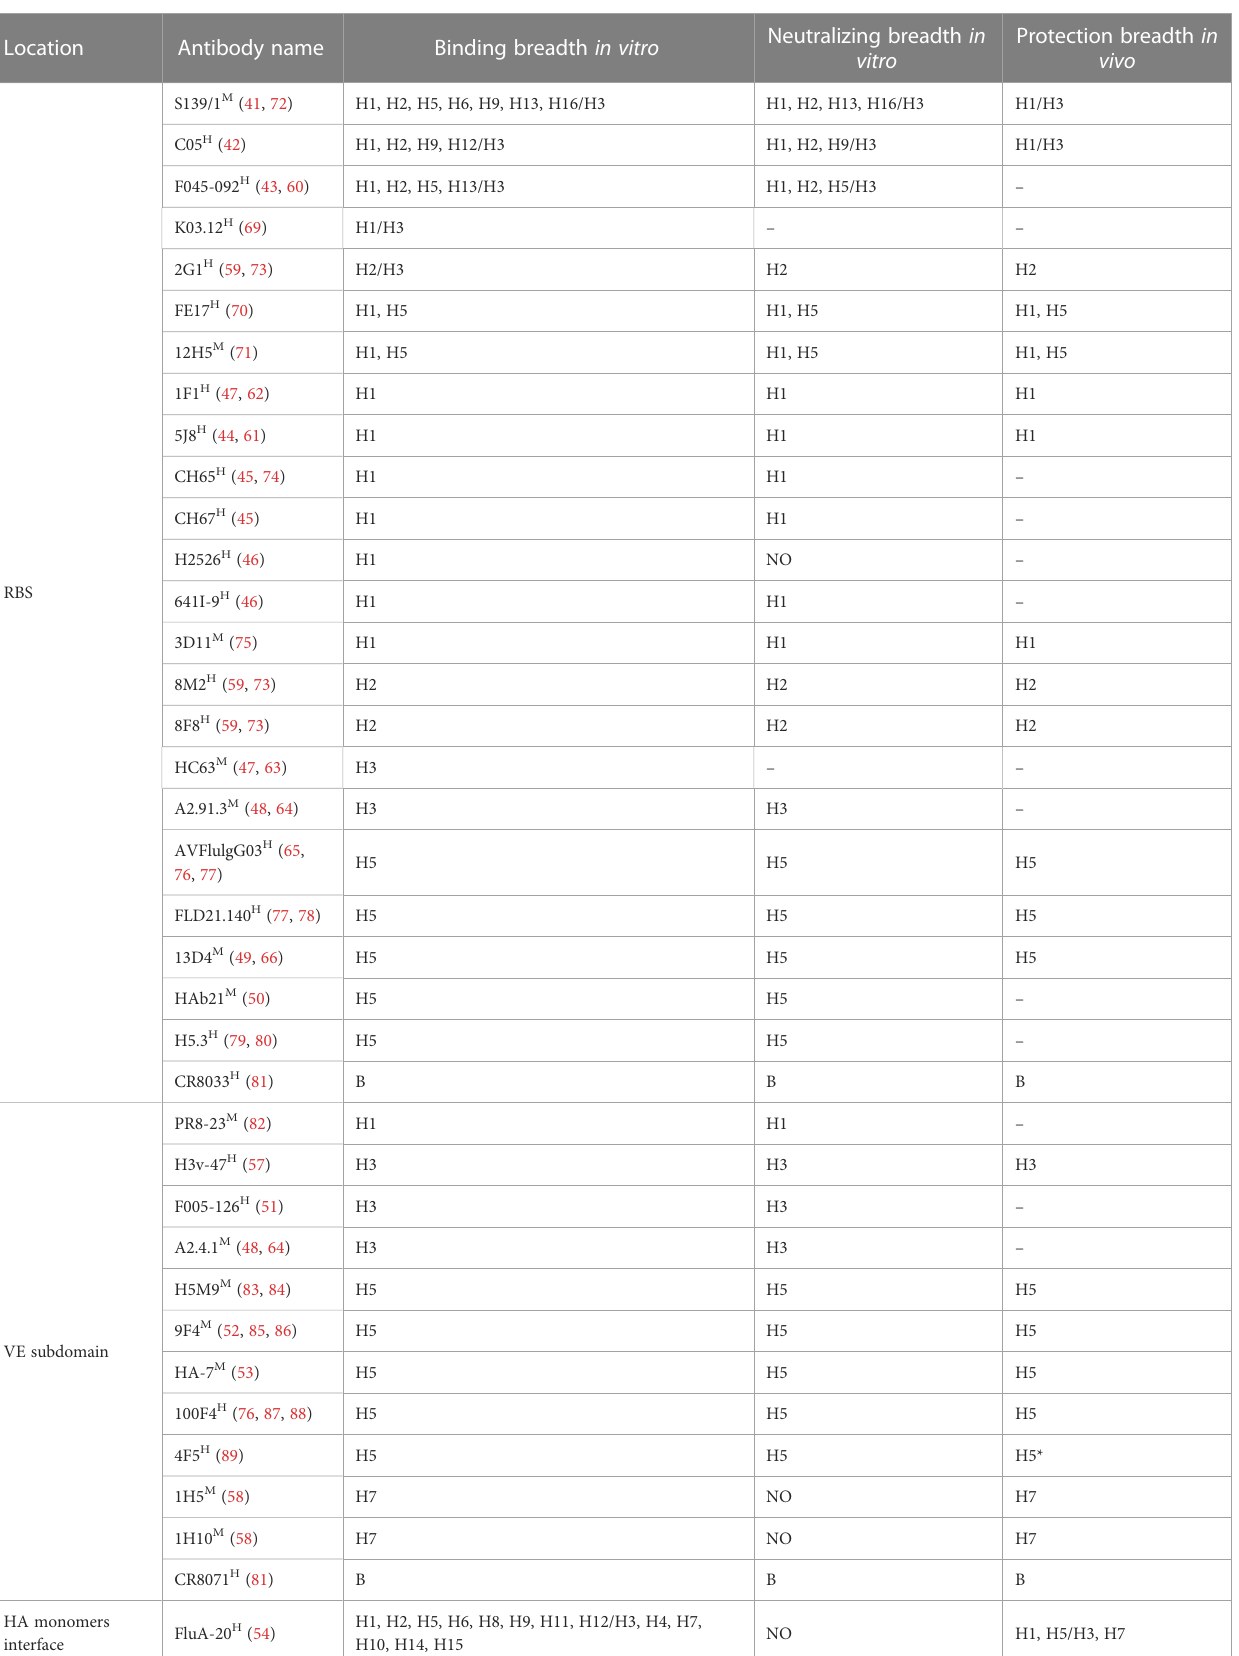
TABLE 1 Characteristics of broadly neutralizing antibody binding to the HA head